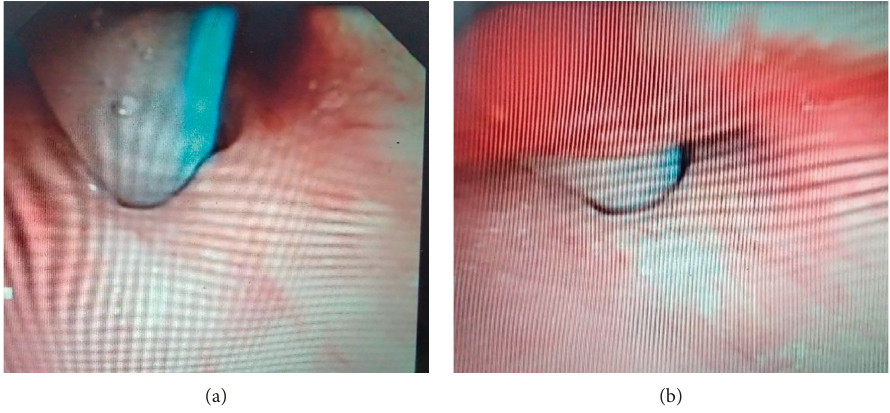
Figure 8: Tracheal stenosis at level of tracheostoma.